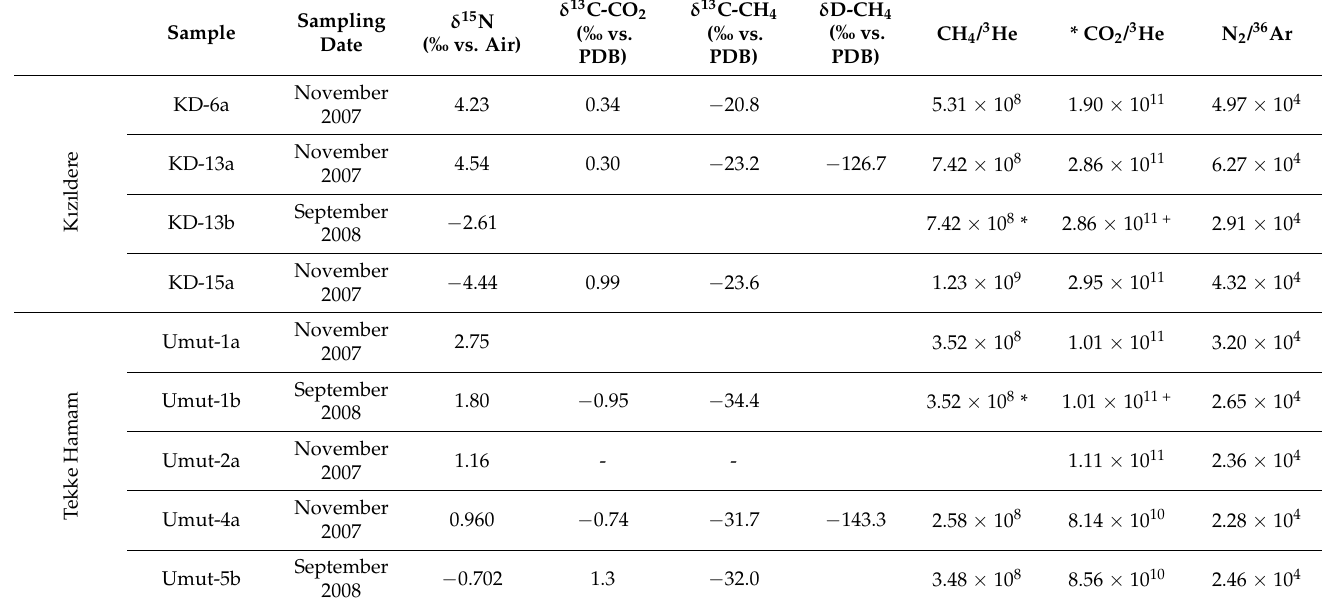
Table 2. Isotopic composition of CO 2 , CH 4 and N 2 of gas samples from Kızıldere and Tekke Hamam, along with their CH 4 / 3 He, CO 2 / 3 He, and N 2 / 36 Ar